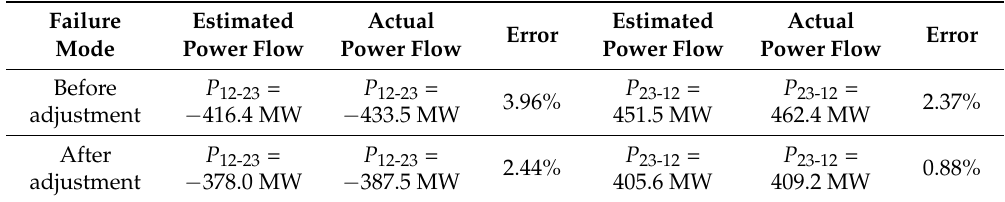
Table 6. The practical case of SE during